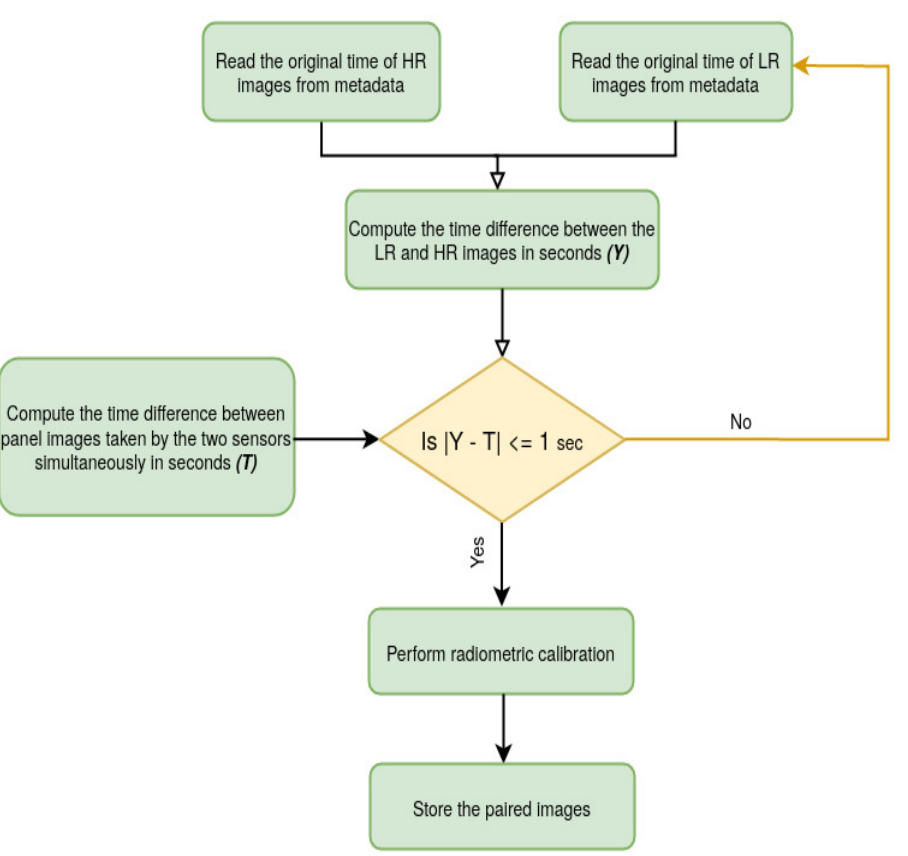
Figure 2. Matching raw LR and HR images while calibrating the LR images radiometrically. ‘sec’ denotes